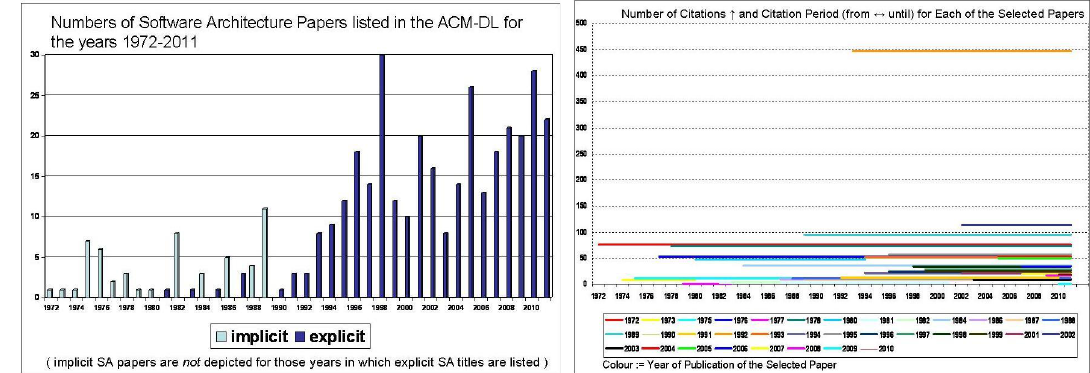
Figure 1. Database from http:/dl.acm.org/ Figure 2. Citation trails with citation